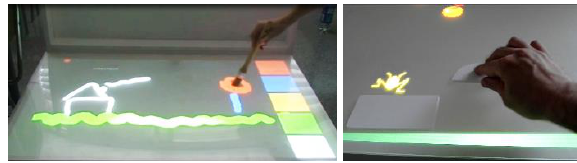
Figure 6. Right: The Paint game. Right: The Bugaboo game.